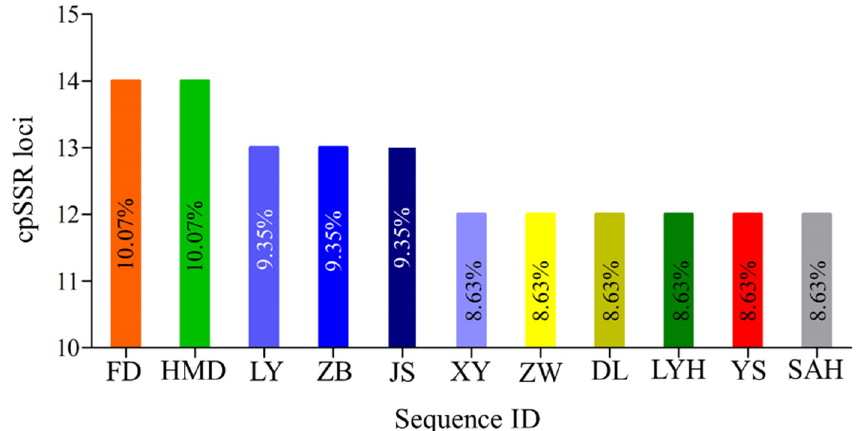
Figure 3. The proportion of cpSSR loci in eleven different samples of P. suffruticosa chloroplast genome